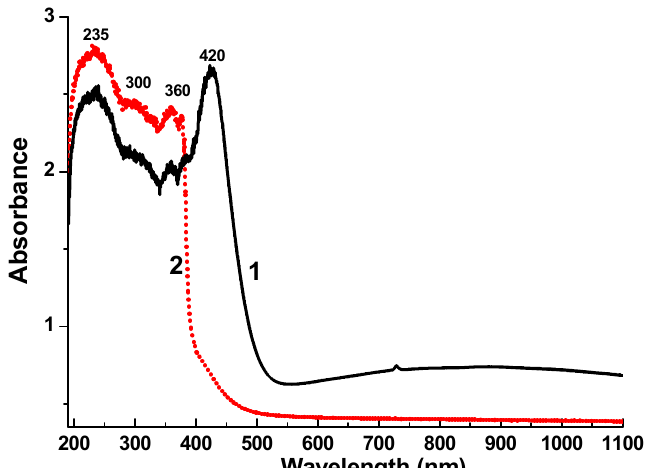
Figure 6. Absorption spectra of as-grown ( 1 ) and annealed ( 2 ) CeAlO 3 single crystals with a thickness of 1 mm.